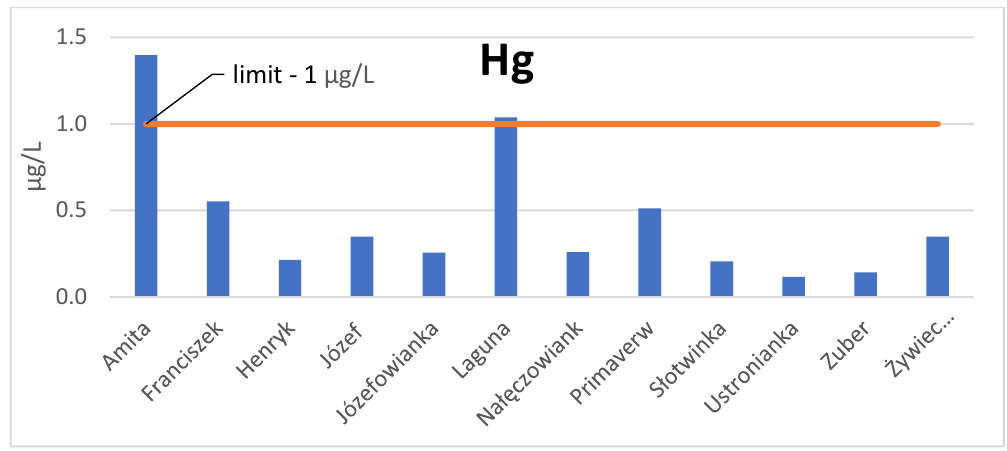
Figure 12. The concentration of mercury in mineral waters ( μg/L ).